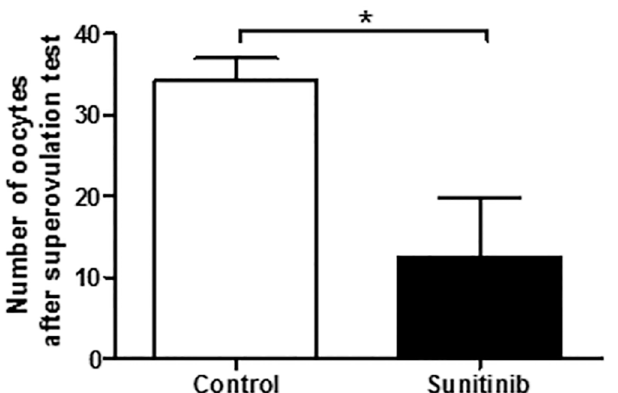
Fig 3. Superovulation test. Number of oocytes obtained after superovulation test in sunitinib-treated (n = 8) and control mice (n = 6).